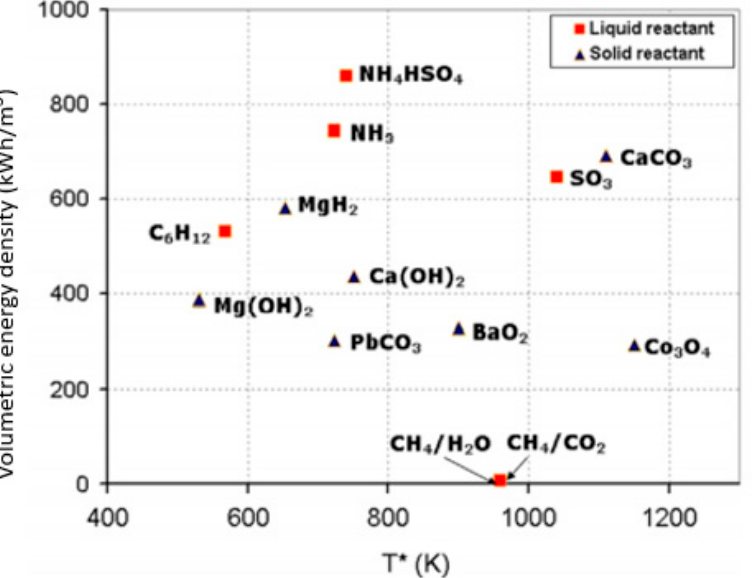
Figure 5. Volumetric energy density of demonstrated thermochemical storage with liquid and solid reactants. Reprint with permission [119]; 2014, Elsevier.